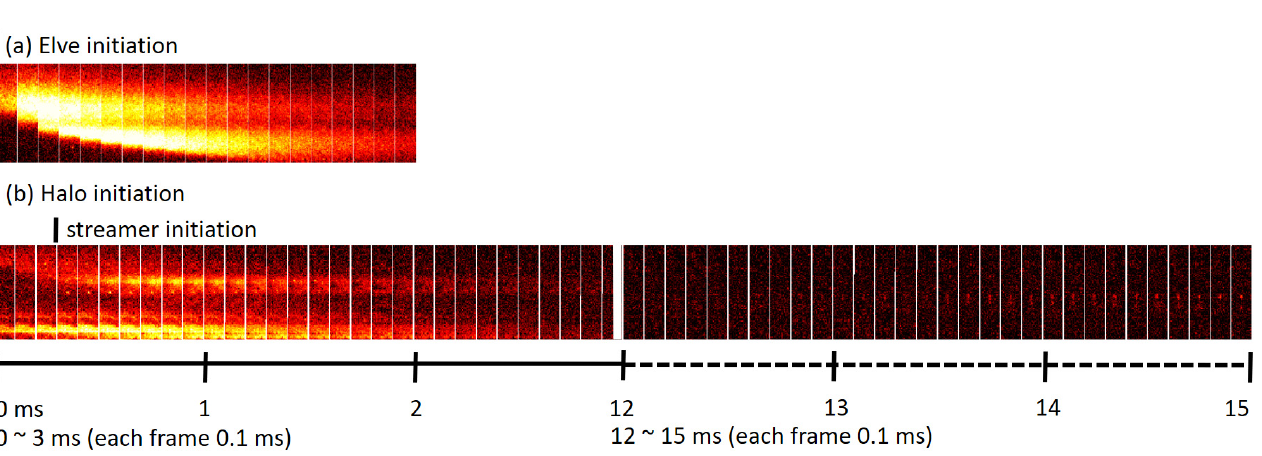
Figure 10. The image sequence for ( a ) the elve event at UT time 13:07:25.9316, also shown in Figure 4 and Figure 9(a1–a5), and ( b ) the sprite halo event at UT time 13:56:28.3870 on June 22 to enhance the features of halo initiation and sprite streamer initiation after 0.3 ms. These images were cropped from the high-speed camera-recorded frames, also shown in Figure 9(b1–b5).